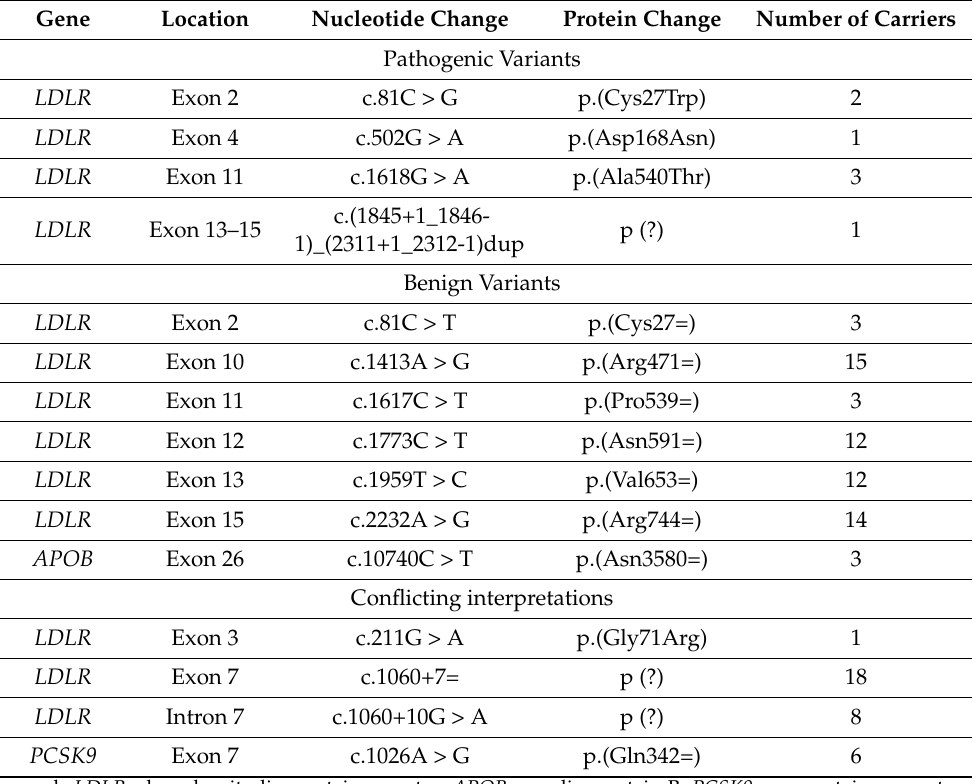
Table 2. LDLR, PCSK9 , and APOB variants identified in the Romania patients.